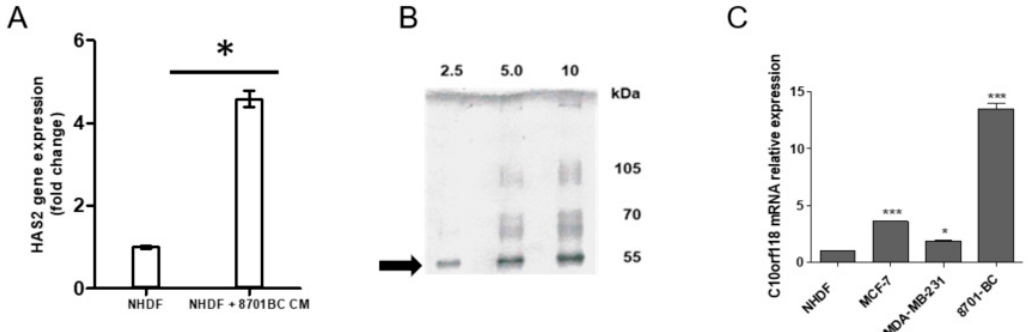
Figure 1. The 8701-BC cells express a soluble factor that is responsible of HAS2 induction in NHDF. ( A ) Quantitative RT-PCR analysis of HAS2 gene in NHDF and NHDF cultured in 8701-BC 48 h CM. The results are expressed as fold change with respect to NHDF cultured in RPMI1640 and each bar represents mean ± S.D. of two independent experiments. * p < 0.05. ( B ) SDS PAGE after Blue Coomassie staining of different amounts in term of total proteins (2.5, 5, 10 µ g respectively) of 8701-BC 48 h CM. Bands at MW of approximately 55 kDa were excised and analyzed by MALDI-TOF as reported in Material and Methods. ( C ) Quantitative RT-PCR analysis of the c10orf118 (Q7z3E2) gene expression level in different breast cancer cell lines (MCF-7, MDA-MB-231 and 8701-BC), expressed as fold change with respect to NHDF. Bars represent mean ± S.D. of triplicate samples. * p < 0.05, *** p < 0.001.